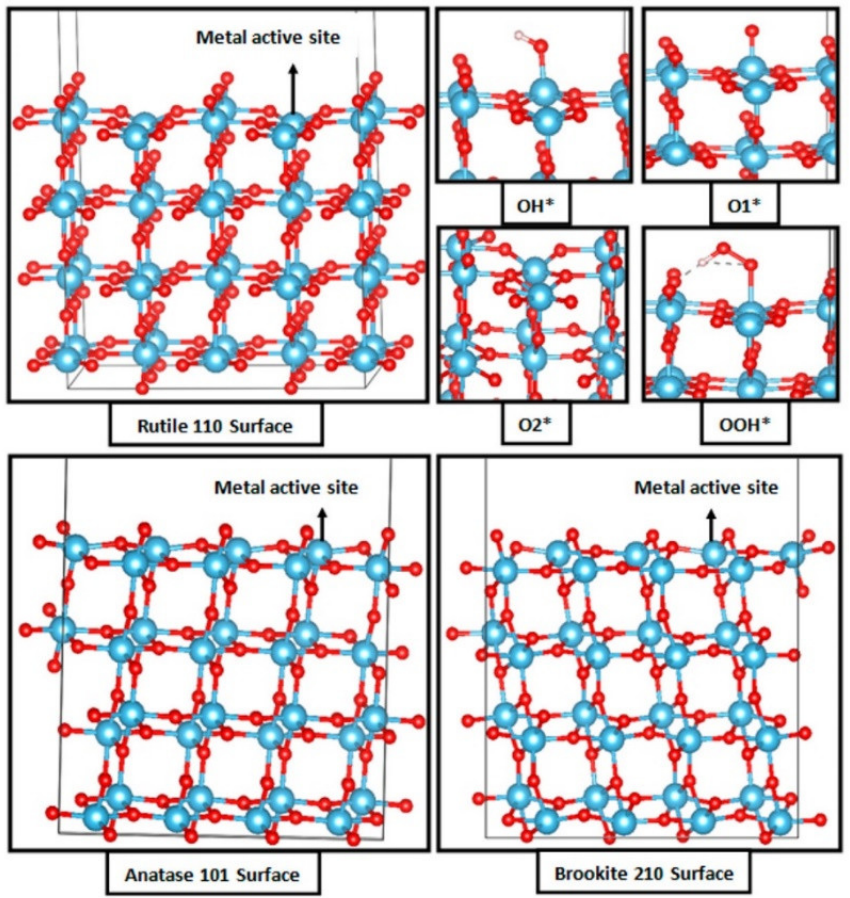
Figure 8. TiO 2 anatase (101), and brookite (210), and rutile (110), surfaces. The intermediate structures: dangling O*, OH*, OOH*, peroxo O* are shown in the upper right corner. Color code: Ti, light blue; O, red; H, white. (Reprinted from ref. [58] with permission from the American Chemical Society. Copyright © 2020, American Chemical Society).